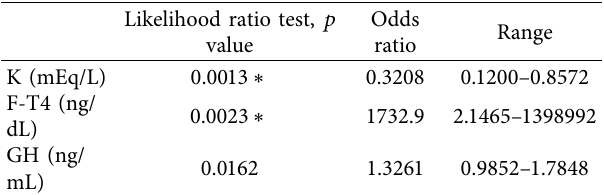
Table 3: Multiple logistic regression analysis for ROSC using K, F- T4, and growth hormone